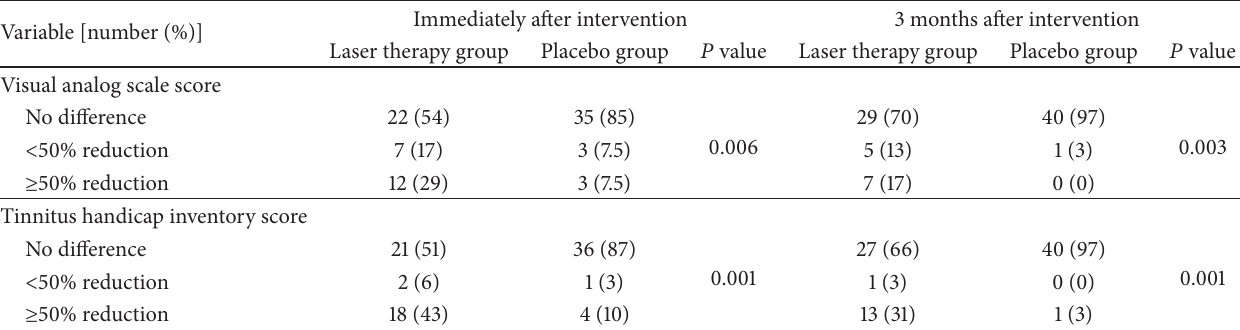
Table 1: Comparison of changes in tinnitus visual analog scaling and tinnitus handicap inventory scores immediately and 3 months after intervention between groups.